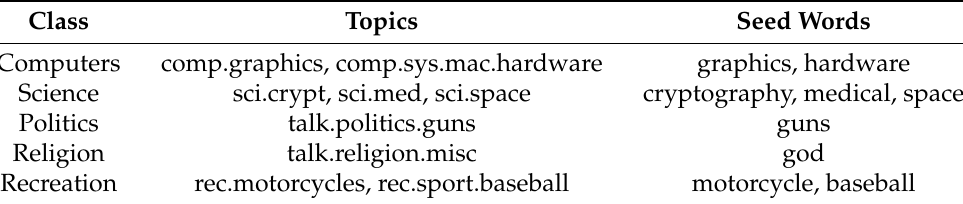
Table 4. Classes, topics, and seed words for 20 Newsgroups.